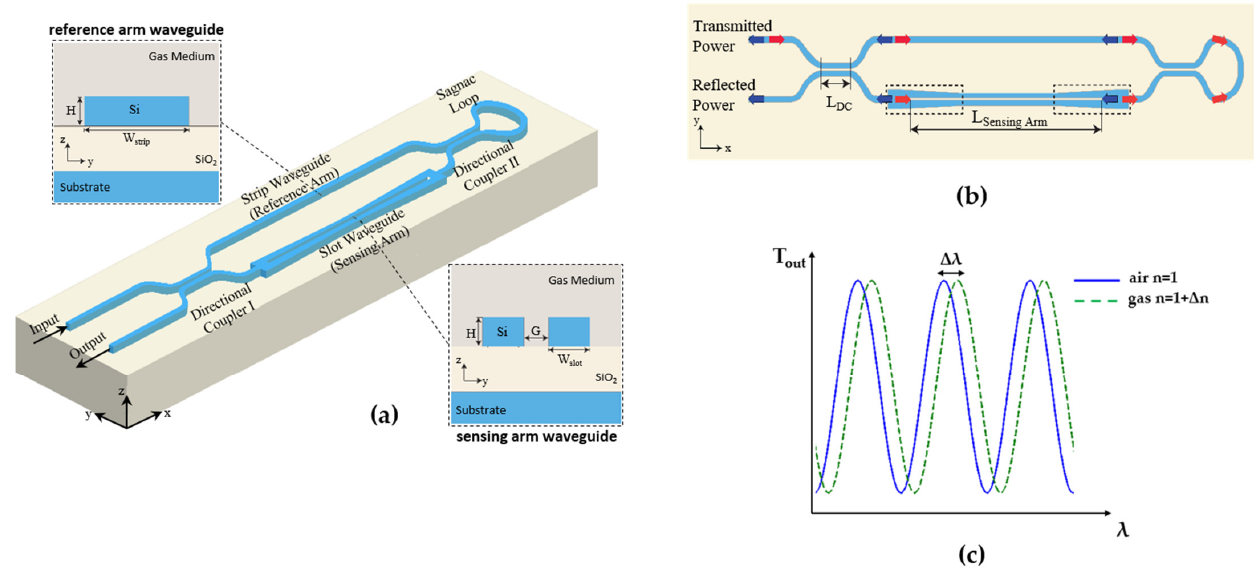
Figure 1. ( a ) Three-dimensional schematic of the LT-MZI gas sensor; insets: cross sections of the strip (reference arm) and slot (sensing arm) waveguides; ( b ) top view of the LT-MZI gas sensor showing the paths for the light beams with red and blue arrows, while marking the mode converters with a dotted-line box; ( c ) schematic of a typical LT-MZI interferometer transmission and the shift in the spectrum that occurs due to gas presence.